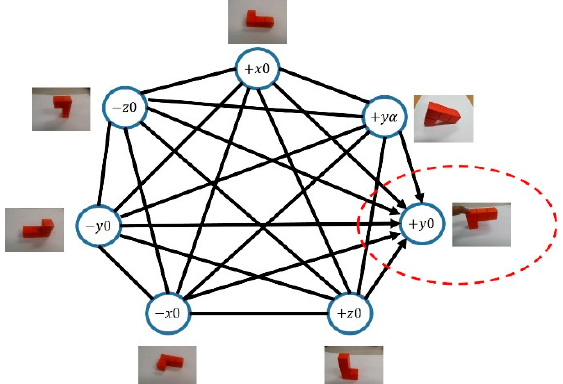
Figure 3. Orientation graph. Orientation families are represented as nodes of the graph and manipulation between two nodes is represented as an edge. An unstable orientation which can be a final pose of the part (encircled in figure with dotted line) in assembly is connected with stable orientations with only incoming edges. But the stable orientations lying on the flat surface of part geometry can have un-directed edges.